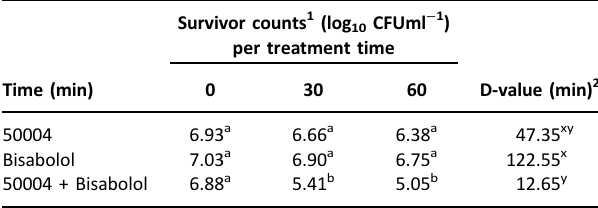
Table 3. Enhancement of C. albicans ATCC 90028